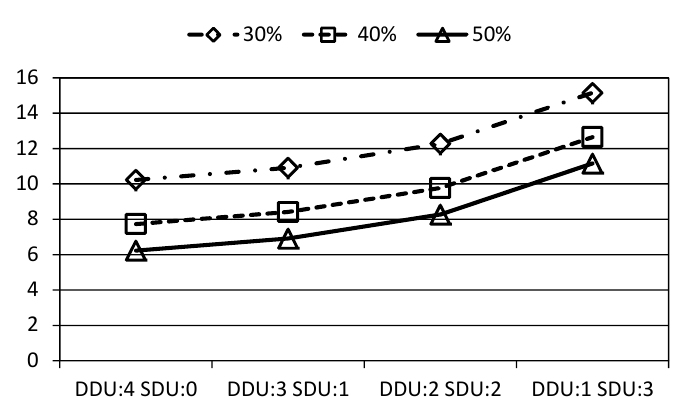
Figure 4. Break-even point for DDU dynamic